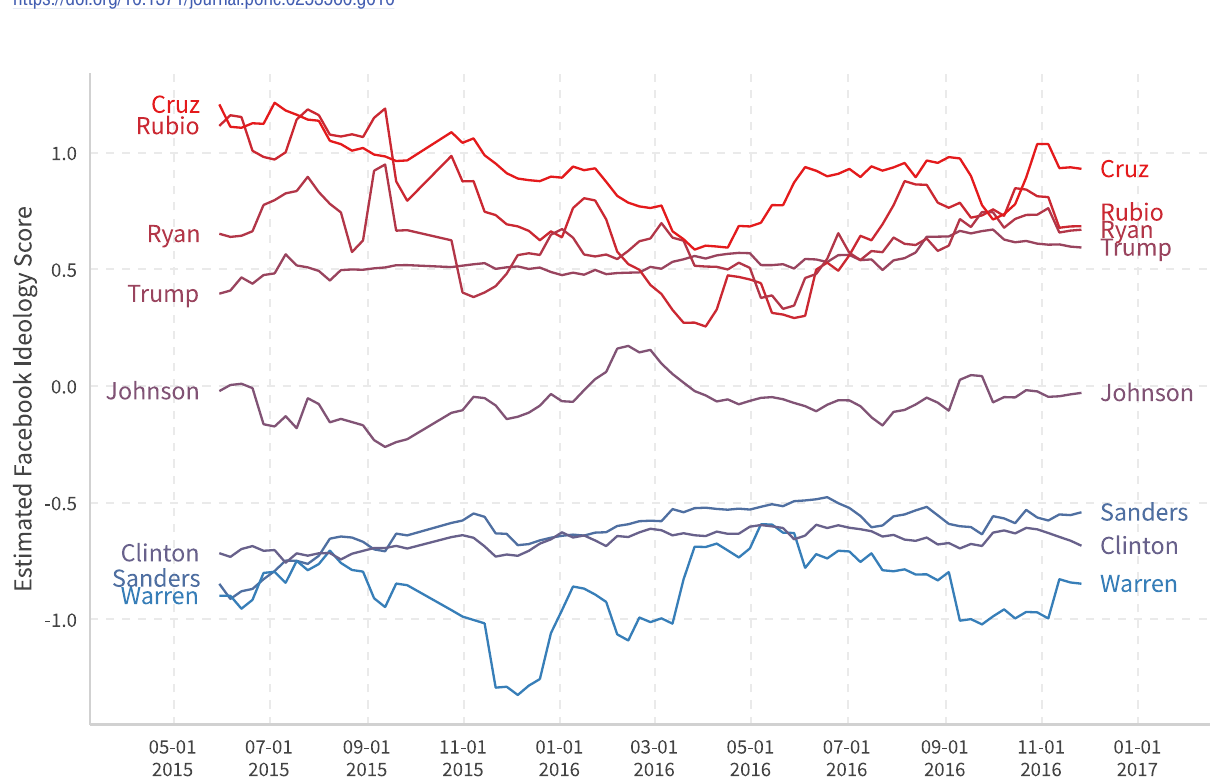
Fig 11. Ideological time series for major 2016 US politicians. We use the data inside a moving window of one month (last 28 days) that updates every week to capture the dynamics of pages. Marco Rubio withdrew on March 15th. Ted Cruz withdrew on May 3rd.